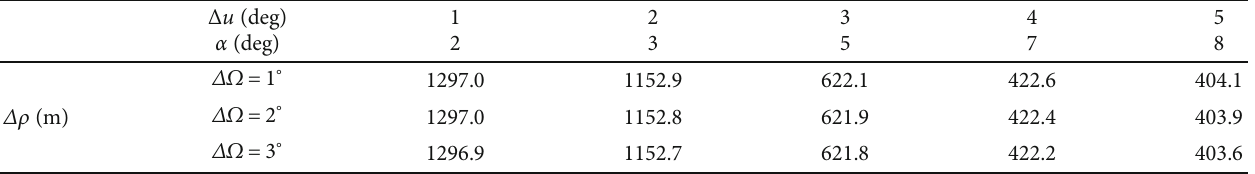
Figure 11: The matching degrees of two-spacecraft formations with di ff erent Δ u , ΔΩ , and α . Table 5: The equivalent ranging errors under di ff erent design parameters.